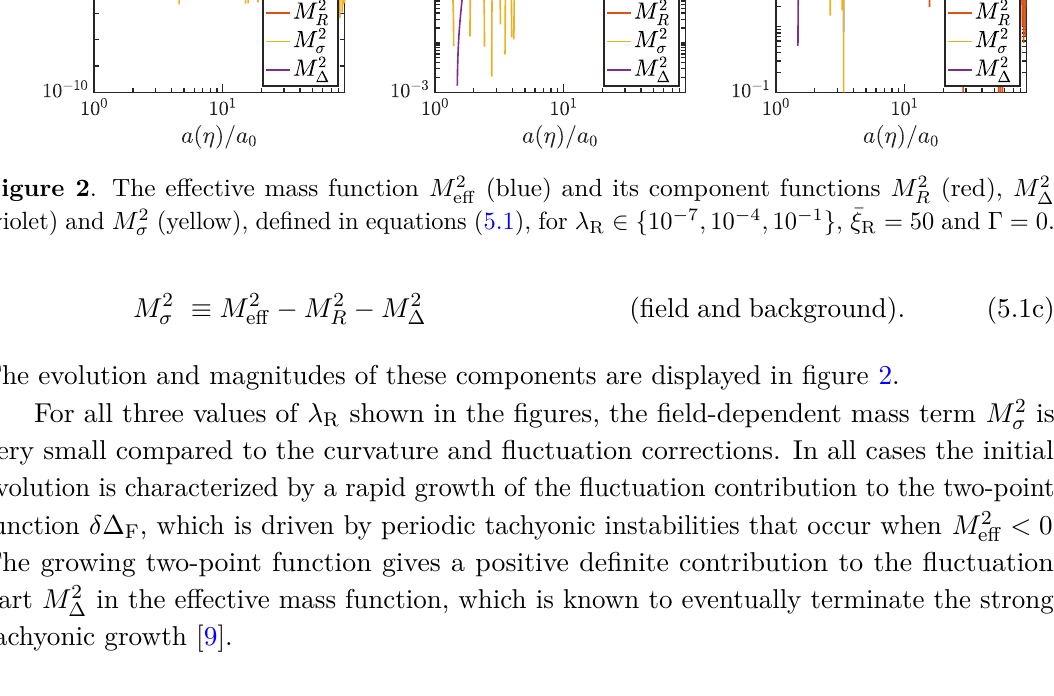
(blue) and its component functions M 2 eff